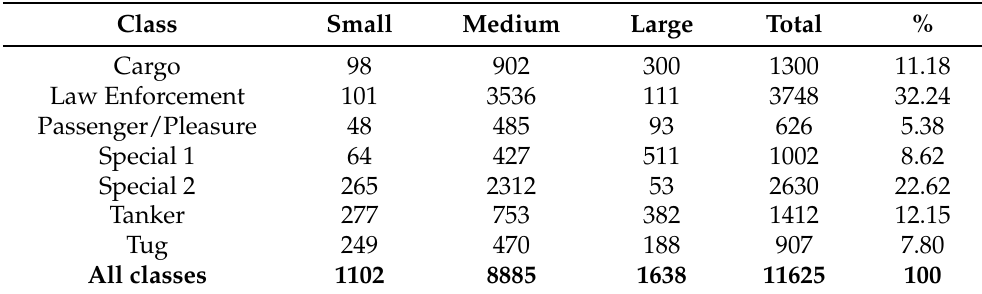
Table 1. Number of masks annotated per class for each area